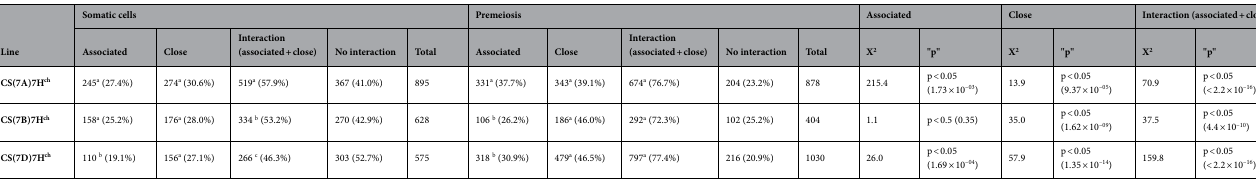
Table 1. Total number and percentage of somatic and premeiotic cells analysed to study chromosome interactions between H. chilense homologues substituted in wheat ( T. aestivum cv. Chinese spring, CS) lines. The significance (p value) of the data between somatic and premeiotic cells at the same level of chromosome interaction within the same wheat line was confirmed by Student’s t test. The robustness of the data was indicated by the X 2 . Data with the same letter within a column represent no significantly differences (when p < 0.05) among wheat lines at the same level of chromosome